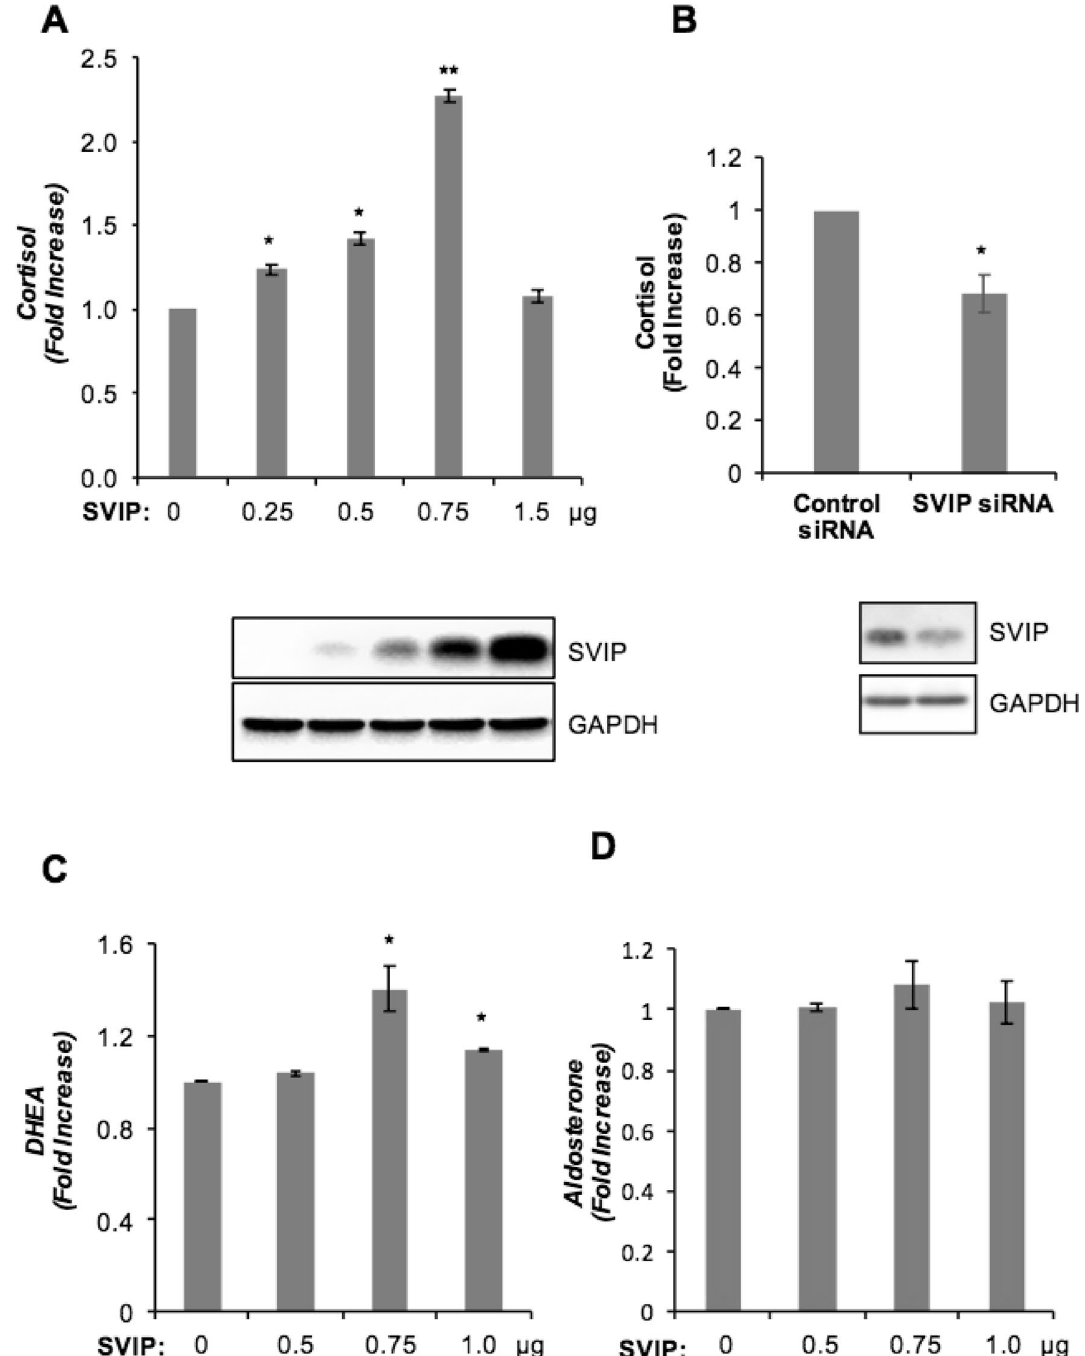
Figure 6. SVIP biphasically regulates cortisol and DHEA secretion in H295R cell line. ( A ) H295R cells were transfected with 0.25, 0.5, 0.75, and 1.5 μg SVIP. Six hours later, the cell culture media was replenished and both cells and cell culture supernatant were harvested after 48 h. The amount of cortisol in the growth media was quantified by ELISA. Cortisol amounts were normalized to the cellular protein concentration and presented as fold change compared to the cells that did not overexpress SVIP. The data graphed represent the mean ± SD. SVIP expression levels were determined by IB. GAPDH was used as loading control. ( B ) H295R cells were transfected with control or SVIP siRNA. At 24 h after transfection, fresh growth media was added. Both cells and cell culture supernatant were harvested 48 h later. Cortisol measurements and evaluation of SVIP expression levels were done as described for ( A ). ( C , D ) H295R cells were transfected with 0.5, 0.75, and 1.0 μg SVIP and processed as described for ( A ). The amount of DHEA ( C ) or aldosterone ( D ) in growth media was quantified by ELISA. Hormone levels were normalized to the cellular protein concentration and presented as fold change compared to cells that did not overexpress SVIP. The data graphed represent the mean ± SD (*p < 0.05, **p < 0.001, n =